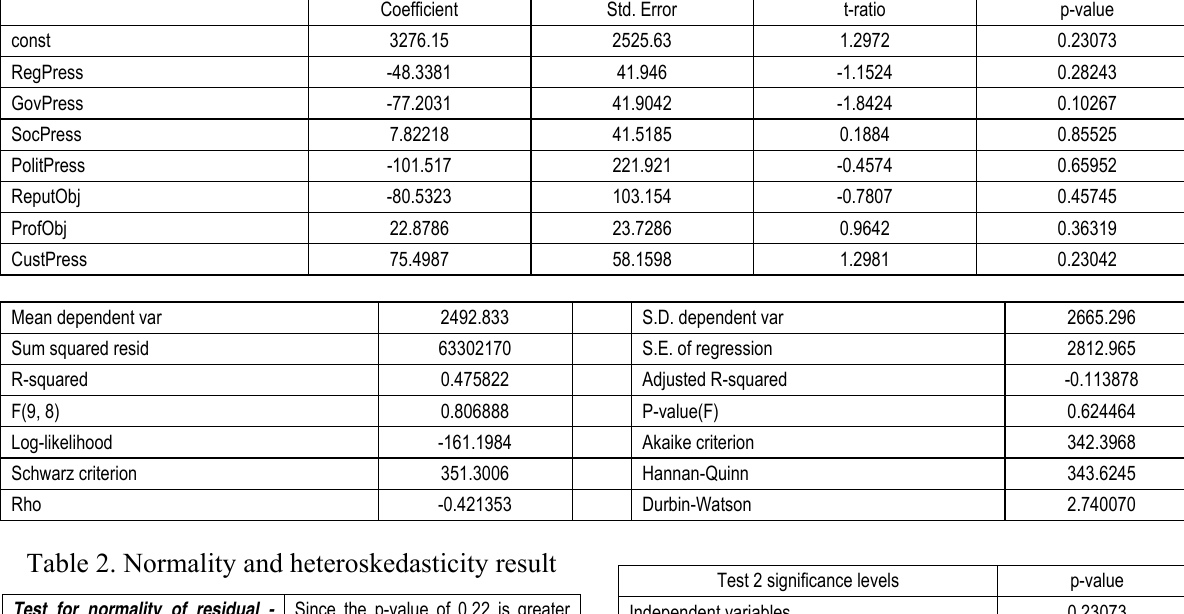
Table 2. Normality and heteroskedasticity result Test for normality of residual - Null hypothesis: error is normally